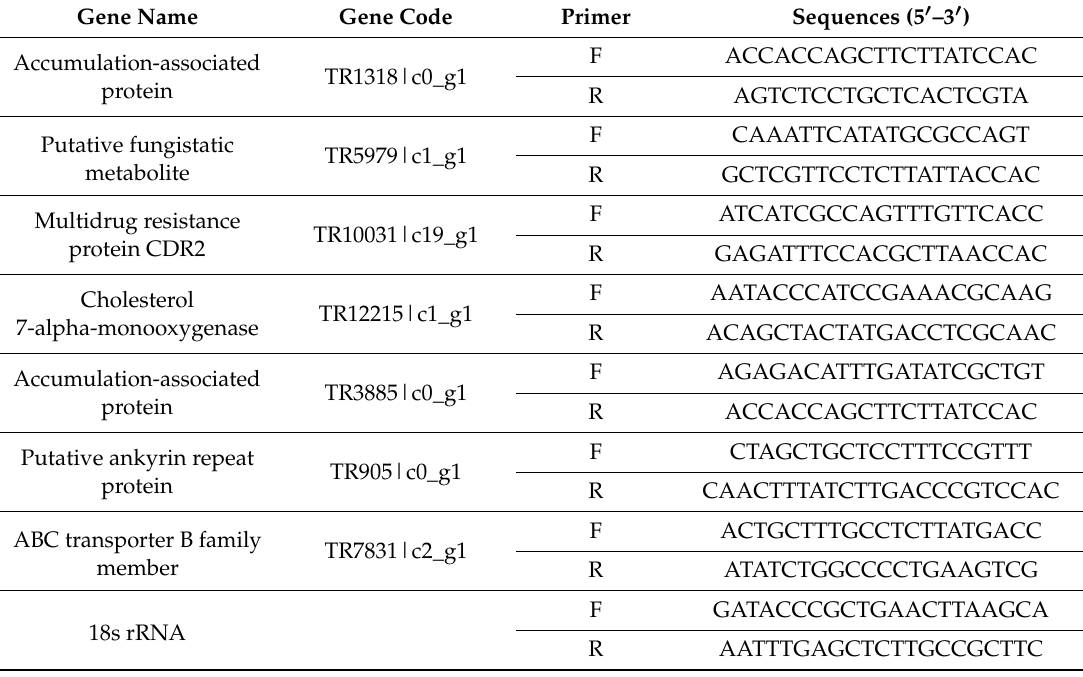
Table 9. Real-time PCR